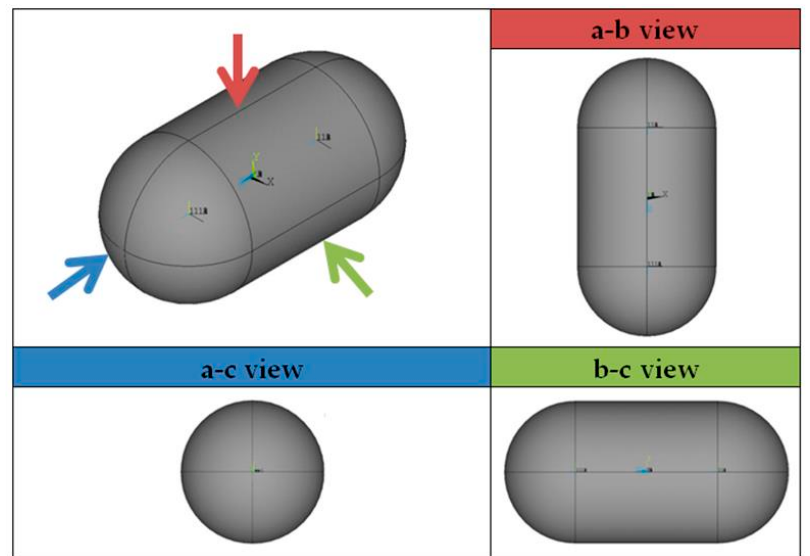
Figure 13. Views of a typical tank configuration.